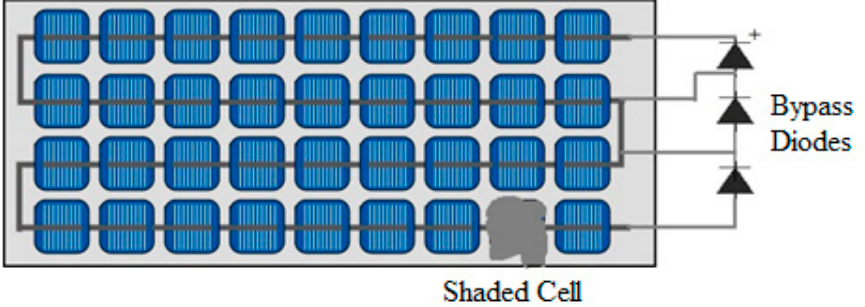
Figure 2. PV module with three bypass diodes dividing the panel into three